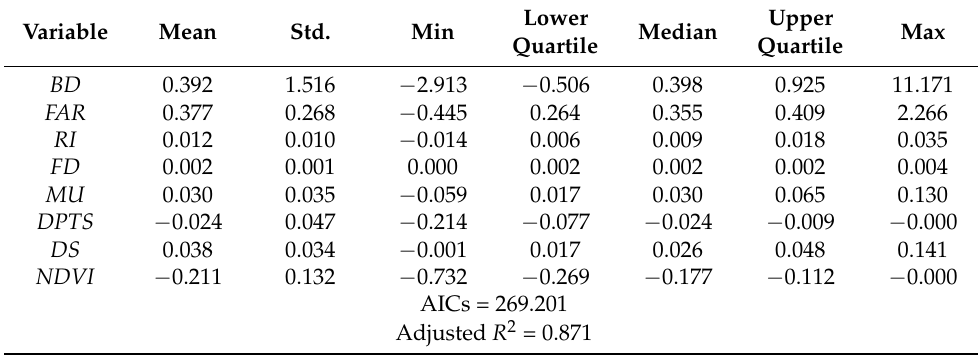
Table 6. Regression results of urban vitality by GWR model on weekends.